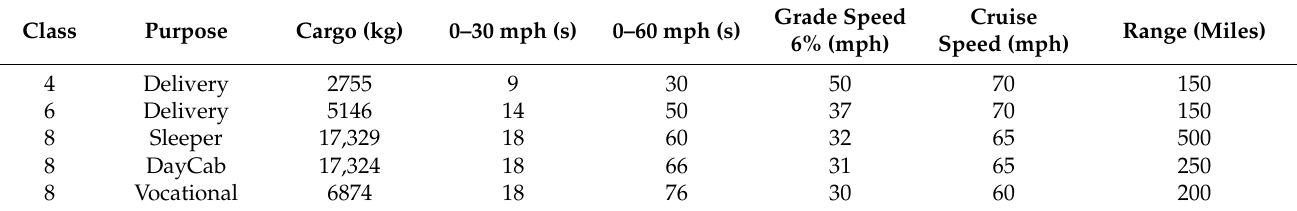
Table 1. Vehicles and required performance capabilities for each use case.